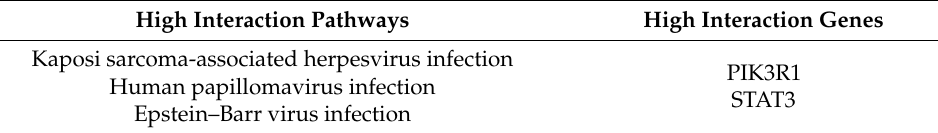
Table 4. Meta-data